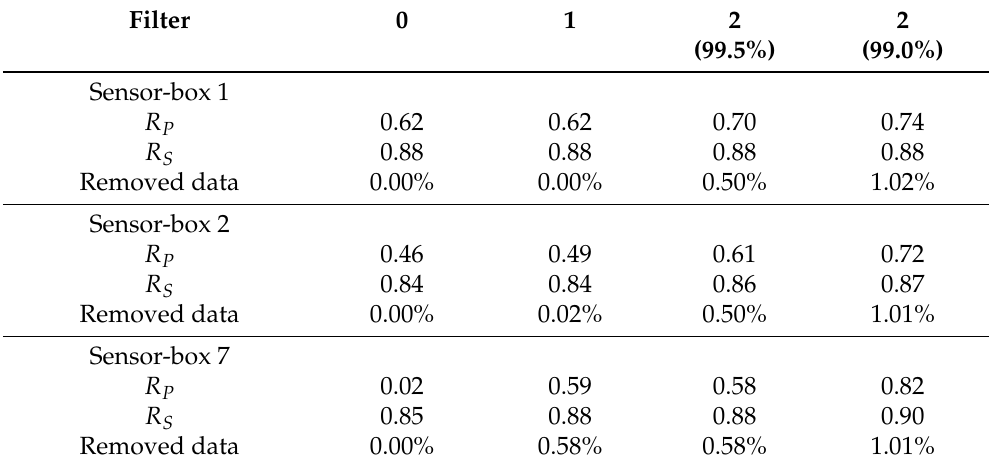
Table A2. Results of static filtering methods applied to raw PM 10 data: correlation between sensor-box and in-luft data versus removed data.